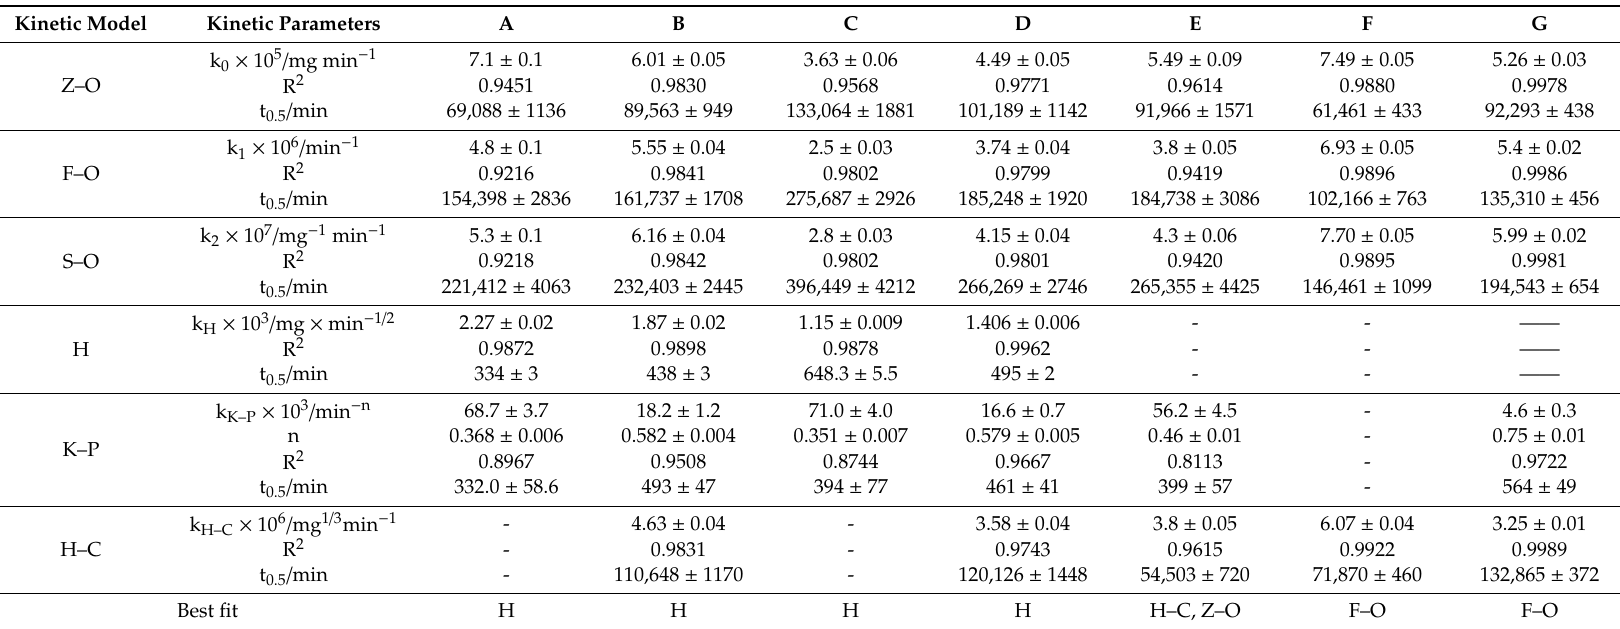
Table 2. The obtained kinetic